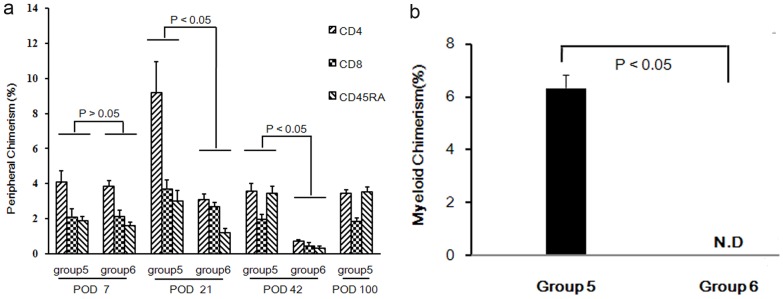
Dynamic changes of peripheral chimerism.Flow cytometry analysis for the presence of donor-specific CD4+/CD8+ T lymphocytes and CD45RA+ B lymphocytes at POD 7, POD 21, and POD 42 of one representative intact allogeneic hind limb recipient with CsA treatment. Levels of donor-specific chimerism were 3.3% in CD4/RT1n cells, 1.2% in CD8/RT1n cells, and 1.6% in CD45RA/RT1n cells at POD 7. They rose to the highest level for donor-origin CD4/RT1n 13.2%, CD8/RT1n 2.9%, and CD45RA/RT1n 2.1% at POD 21, remained at 3.6% CD4/RT1n, 2.0% CD8/RT1n, and 3.0% CD45RA/RT1n. The background levels observed in isograft controls were assessed at 0.3%, 0.2%, and 0.3%, respectively.